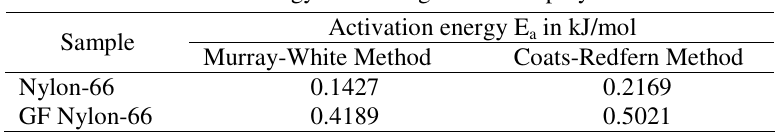
Table 6. Activation energy for the degradation of polymer